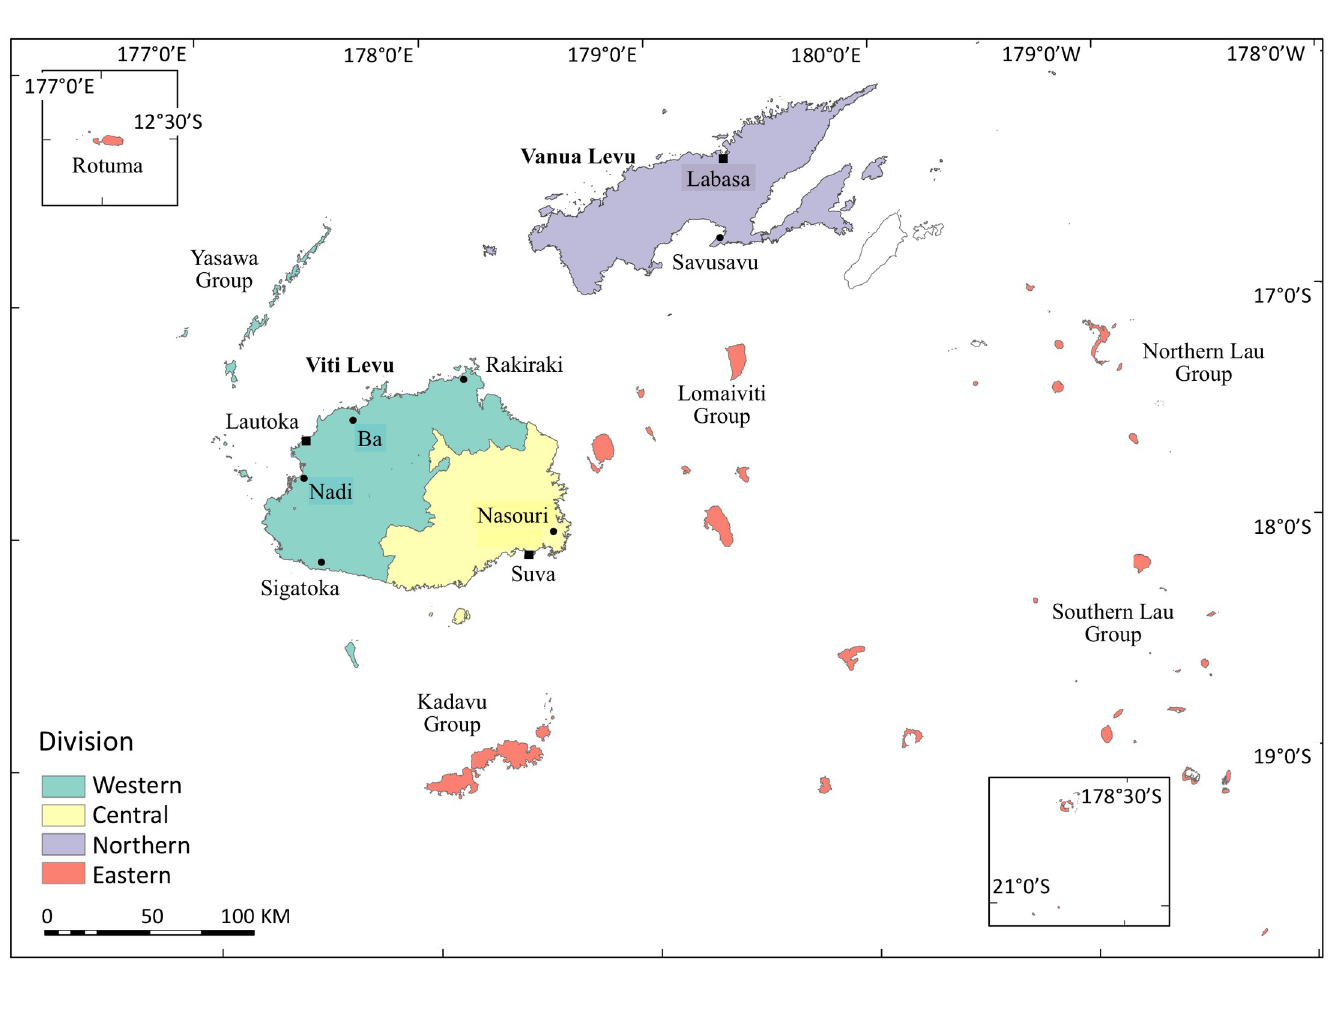
Fig 1. Sketch map of Fiji showing the 4 Divisions of Fiji covered by the STH prevalence assessment. The Northern Division here excludes the Taveuni